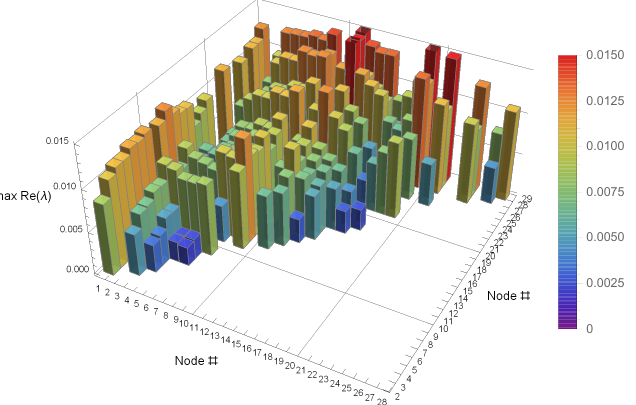
Figure 17. IEEE 39 bus: max ( Re ( λ )) for synchronverters connected to different